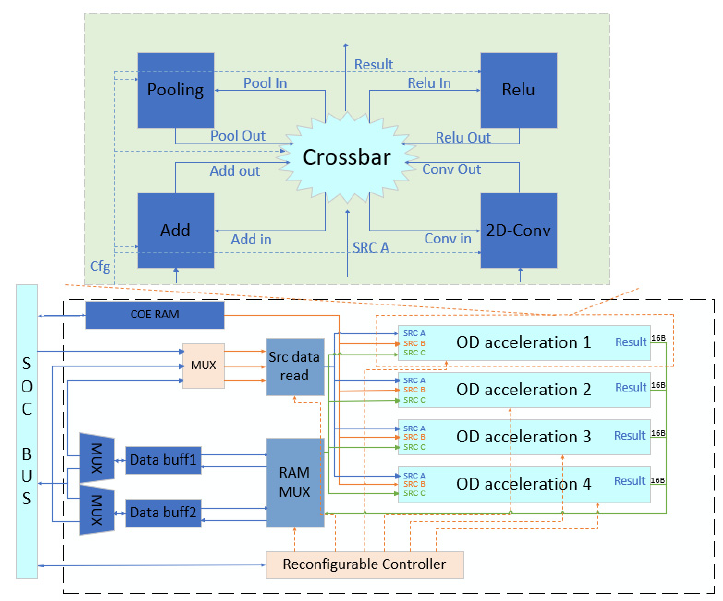
Figure 1. Structure diagram of the target detection algorithm accelerator.